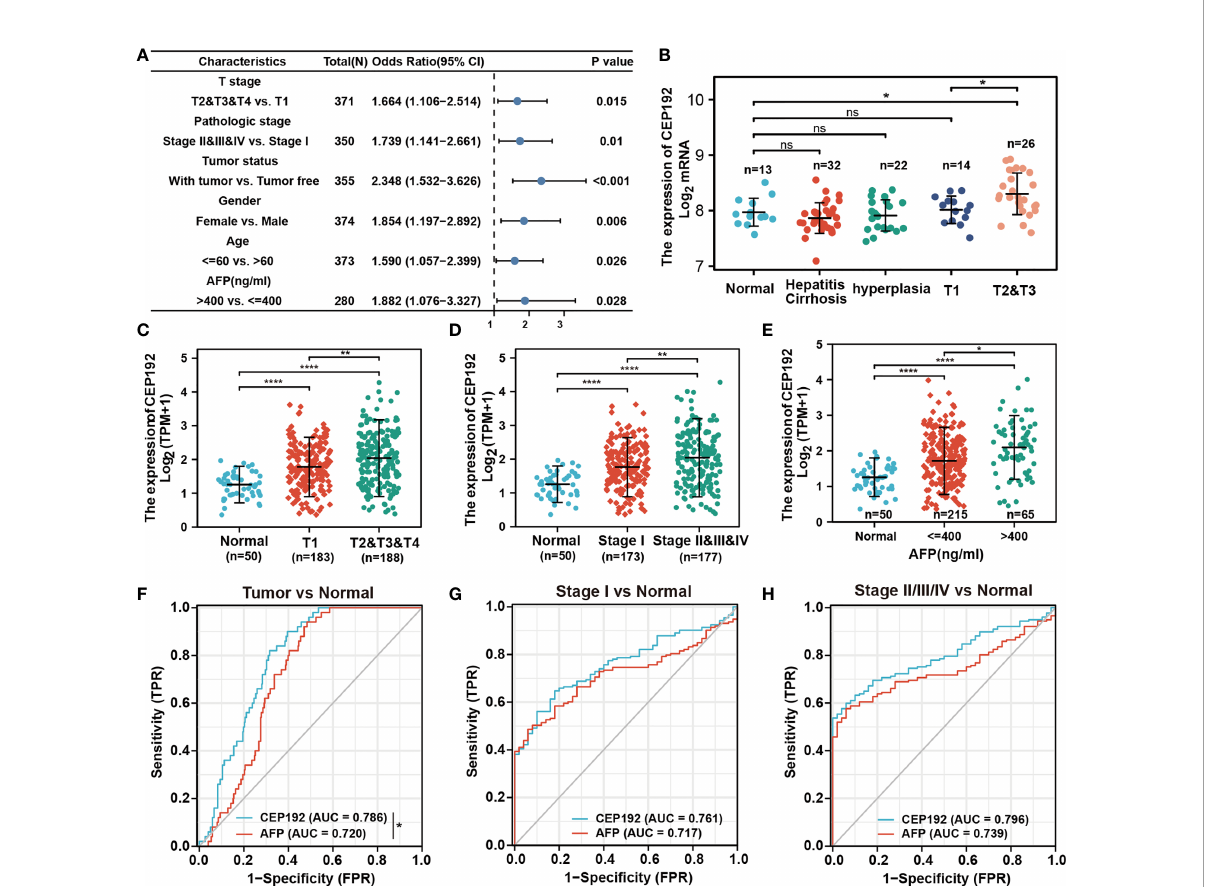
FIGURE 2 CEP192 was correlated with advanced clinicopathological features of HCC patients. (A) CEP192 was shown to be highly associated with the T stage ( n = 371), pathologic stage ( n = 350), tumor status ( n = 355), gender ( n = 374), age ( n = 373), and AFP secretion level ( n = 280); generalized linear model (GLM). (B) The expression levels of CEP192 in precancerous lesions including hepatitis ( n = 13), cirrhosis ( n = 32), and hyperplasia ( n = 22), as well as in HCC tissues at different T stages (T1, n = 14; T2&T3, n = 26) (GSE89377); mean ± SEM, ordinary one-way ANOVA, * p <0.05. (C) CEP192 gene expression (RNA-seq) of TCGA-LIHC samples at different T stages of liver cancer (Normal, n = 50; T1, n = 183; T2&T3&T4, n = 188); mean ± SEM, ordinary one-way ANOVA, ** p <0.01, **** p <0.0001. (D) CEP192 gene expression (RNA-seq) of TCGA-LIHC samples at different pathologic stages of liver cancer (Normal, n = 50; Stage I, n = 173; Stage II&III&IV, n = 177); mean ± SEM, ordinary one-way ANOVA, ** p <0.01, **** p <0.0001. (E) CEP192 gene expression (RNA-seq) from TCGA-LIHC samples with different AFP secretion levels [Normal, n = 50; AFP (ng/ml) ≤ 400, n = 215; AFP (ng/ml) > 400, n = 65]; mean ± SEM, ordinary one-way ANOVA, * p <0.05, **** p <0.0001. (F – H) Receiver operating characteristic (ROC) curves and the area under the ROC curve (AUC) were used to evaluate the sensitivity and speci fi city of CEP192 expression in diagnostic performance of HCC (DeLong ’ s test, * p = 0.049) (F) , early-stage HCC (G) , and late-stage HCC (H) . NS, non signi fi